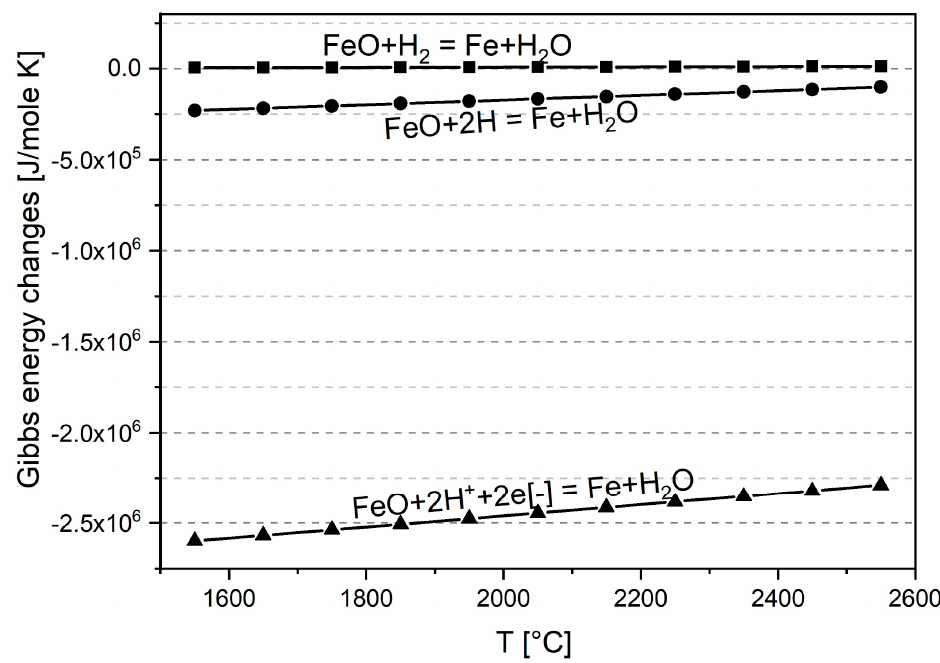
Figure 6. Δ G°–T curve for the reduction of FeO with different hydrogen species calculated by FactSage™ 7.1 (Database: FactPS 2017).